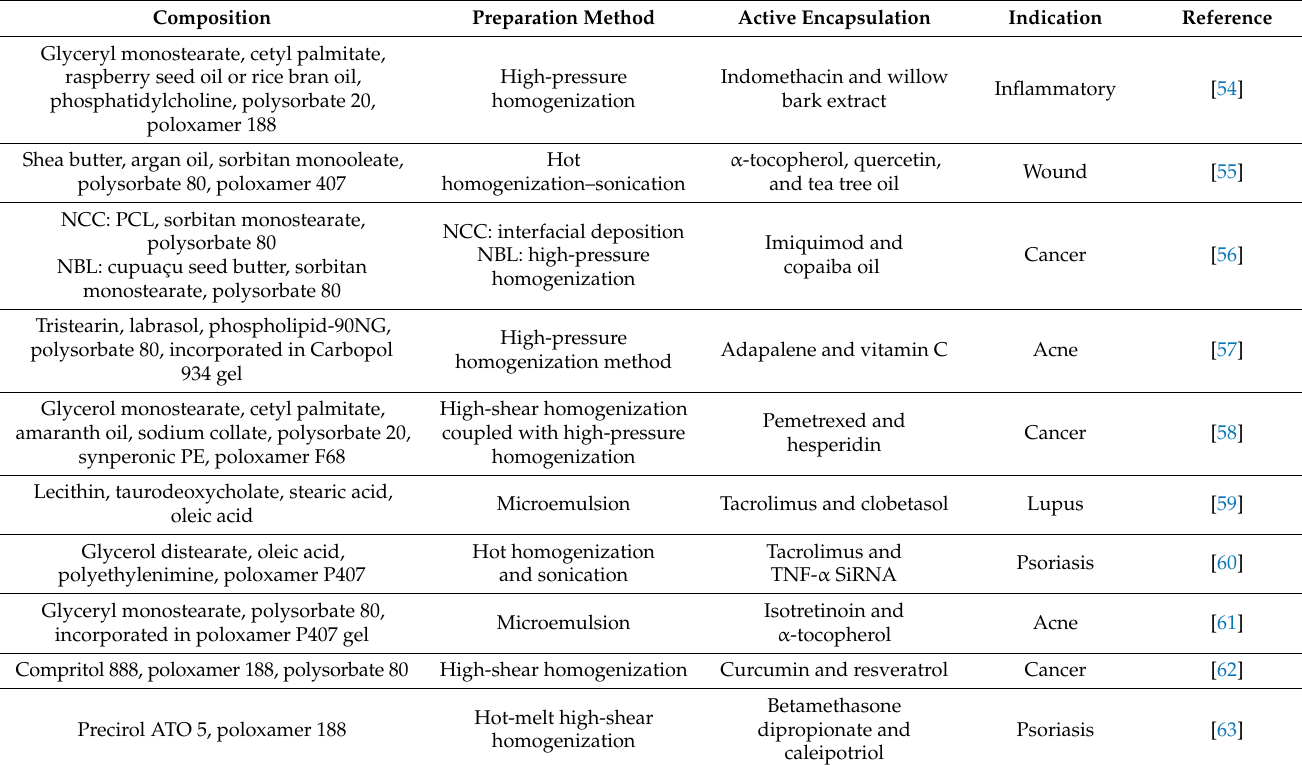
Table 2. Examples of the lipid nanoparticles and the diseases that can benefit from co-encapsulated